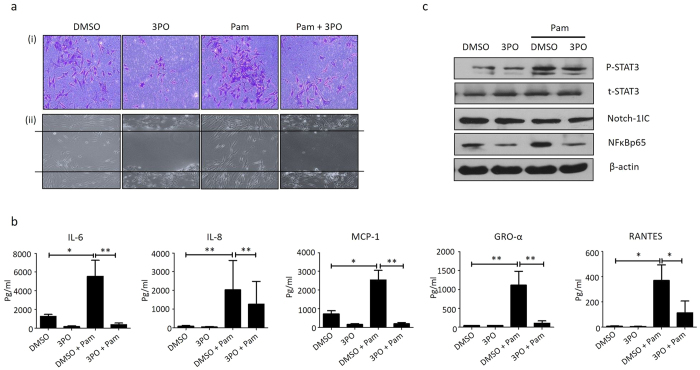
TLR2-induces pro-inflammatory processes are inhibited in the presence of glycolytic inhibitor 3PO in vitro.(a) Representative images displaying RASFC cell invasion (i) (n = 1) and migration (ii) (n = 3) under Pam3CSK4 (1 μg/ml) stimulation (24 hrs) in the presence of absence of 3PO (20 μM) or DMSO vehicle control. (b) Bar graphs demonstrating secretion of IL-6, IL-8, MCP-1, GRO-α and RANTES in RASFC (n = 7) stimulated with Pam3CSK4 (1 μg/ml) for 24 hrs in the presence of absence of 3PO (20 μM) or DMSO vehicle control. (c) Representative cropped western blots demonstrating P-STAT3, Notch-1IC and NFĸBp65 expression in K4IM synoviocytes stimulated with Pam3CSK4 (1 μg/ml) in the presence or absence of 3PO (20 μM) or DMSO vehicle control for 24 hrs (n = 1). T-STAT3 was used as a loading control for P-STAT3 and β-actin was used as a loading control for Notch-1IC and NFĸBp65. Data was analysed by Wilcoxin Signed Rank test and is represented as Mean ± SEM, *p < 0.05, **p < 0.01 significantly different to control.